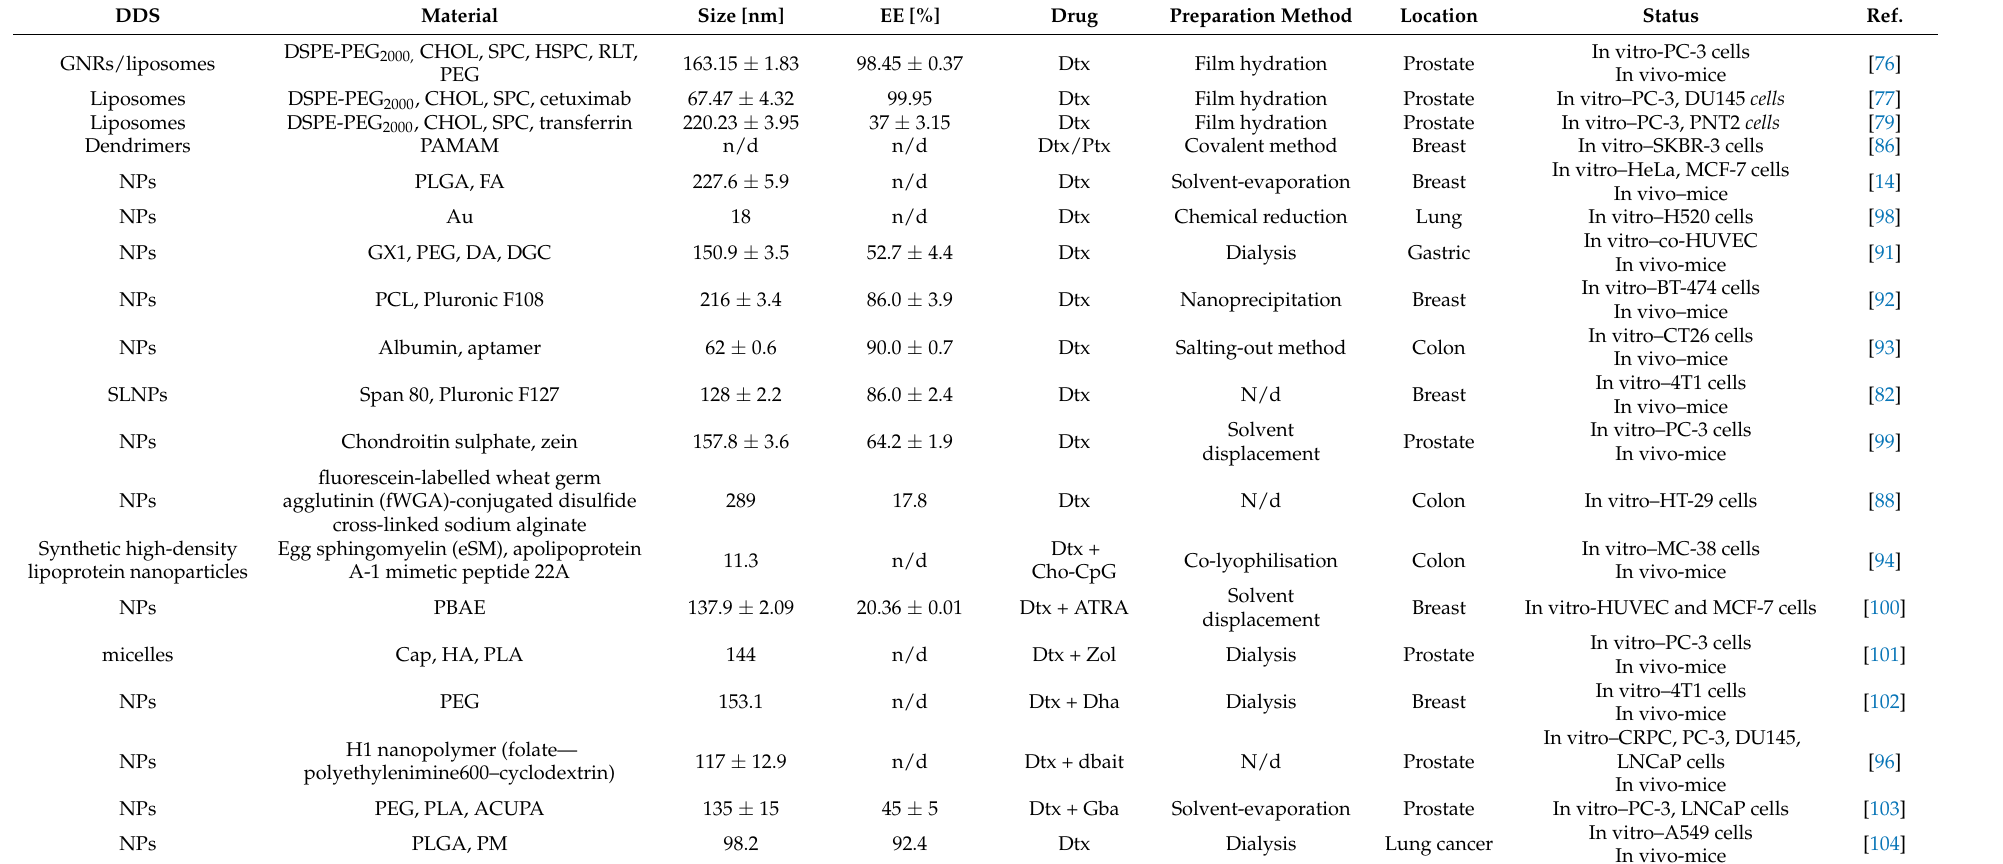
Table 1. Examples of Dtx–loaded delivery systems for anticancer